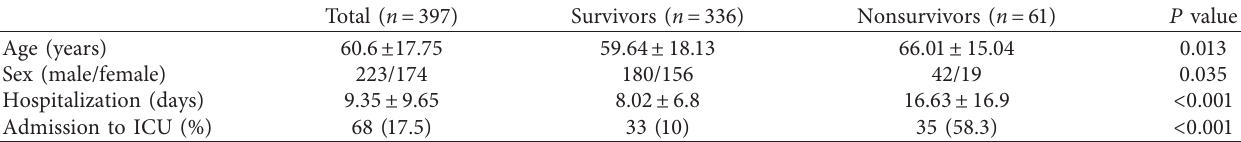
Table 1: Characteristics of survivors and nonsurvivors of COVID-19.